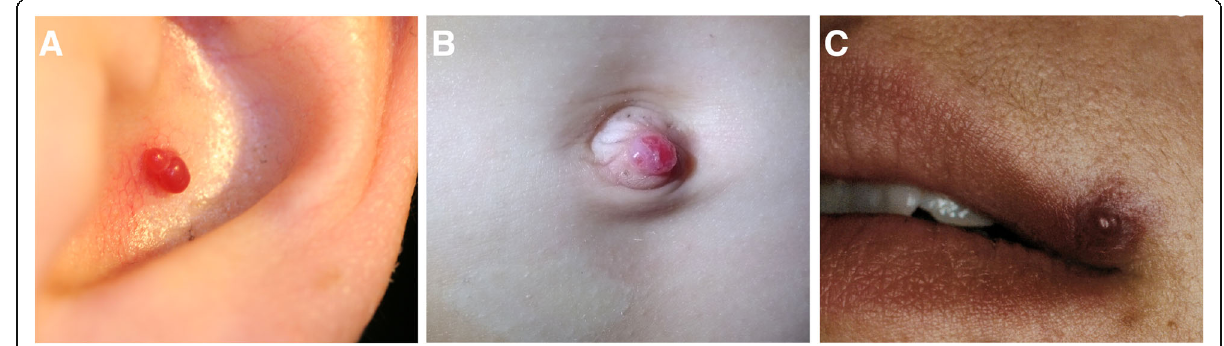
Fig. 5 Various presentations of a pyogenic granuloma in the auricle ( a ), at the umbilicus ( b ) and at the lip ( c